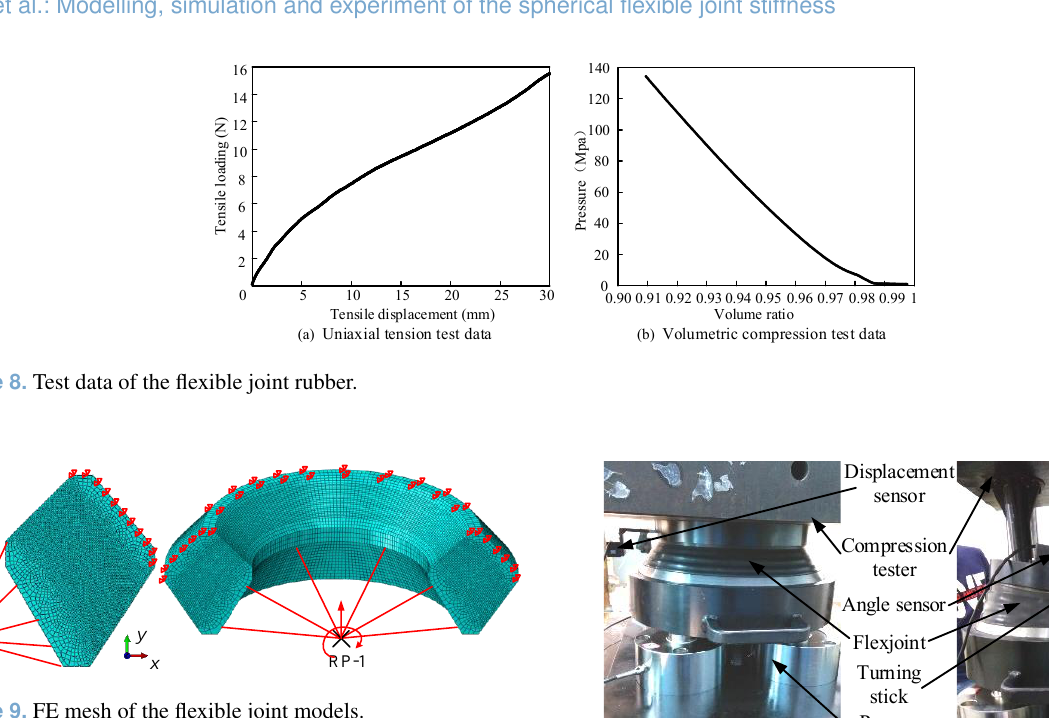
Figure 9. FE mesh of the flexible joint models.